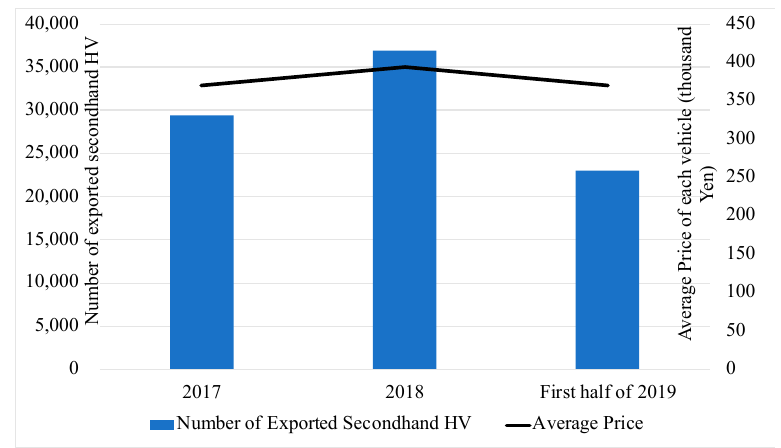
Figure 5. The average price of exported secondhand HV to Mongolia. Source: Figure made by the author based on the data from Trade Statistic of Japan [7].